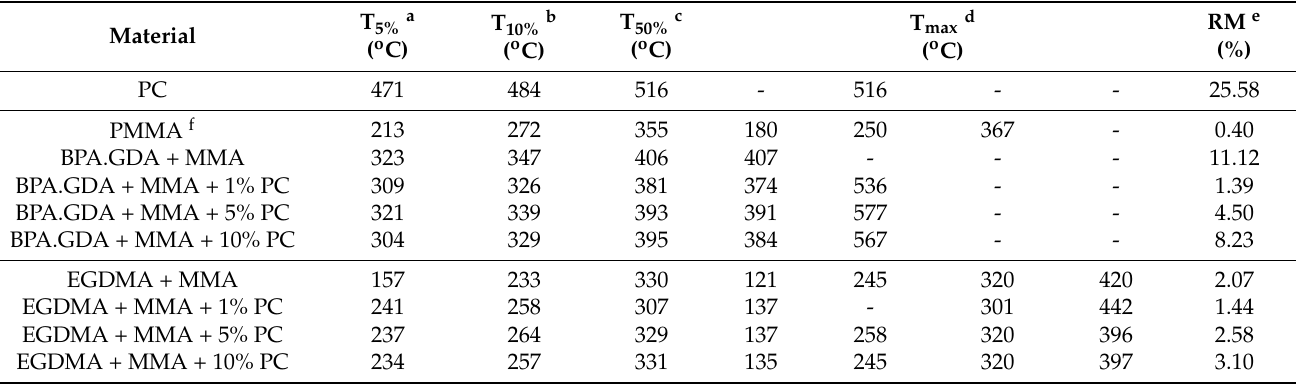
Table 2. Thermogravimetric data of the obtained blends.